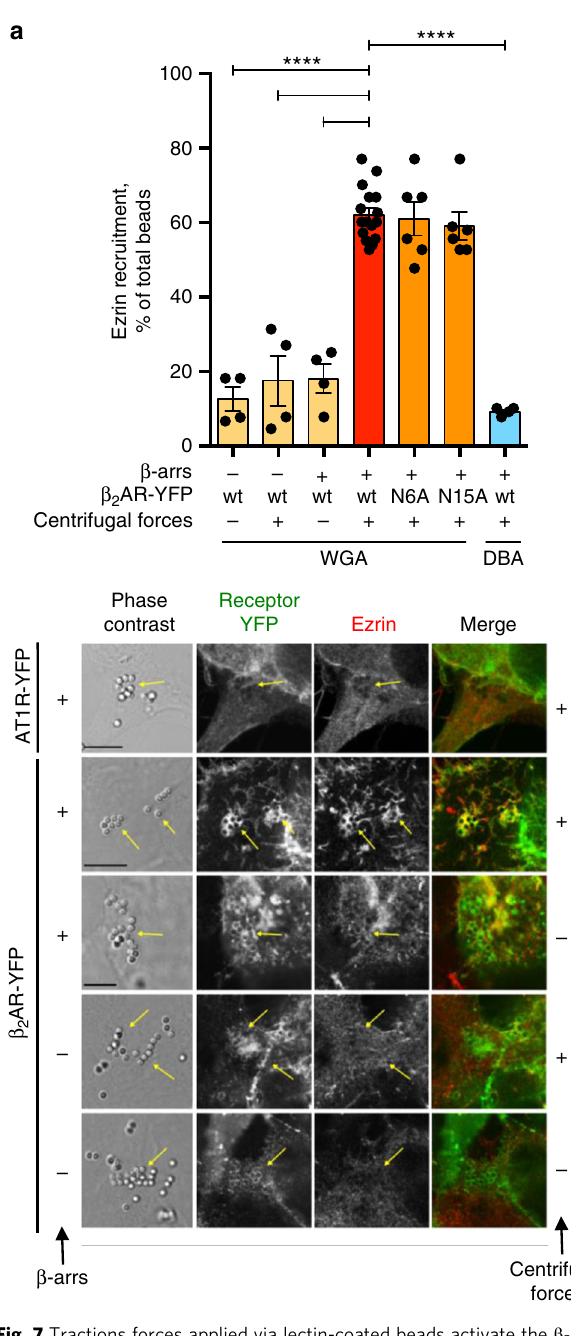
Fig. 7 Tractions forces applied via lectin-coated beads activate the β 2 AR. a Neutravidin-agarose beads (1 µ m) were coated with biotinylated WGA or control dolichos bi fl orus agglutinin (DBA) as described in Methods. The latter lectin has speci fi city for α -linked N -acetylgalactosamine. They were then let to sediment for 1 h on HEK-293 cells expressing the indicated YFP-tagged wt of mutant receptors, with or without exogenous β -arrestins ( β -arrs), in 2 cm 2 well plates before 15 min of orbital rotation at 100 r.p.m. Cells were fi xed and labeled with anti-ezrin antibodies. Ezrin recruitment under beads was used as a marker of receptor signaling. **** P < 0.0001, ANOVA. b Representative images of experiments in a are shown, bar: 10 µ m. The AT1R was used as a negative